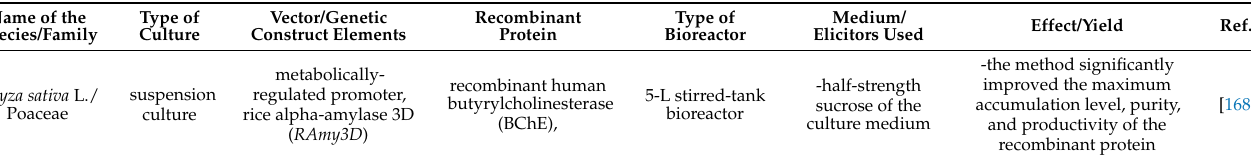
Table 2. Overproduction of recombinant proteins in transgenic cultures grown in